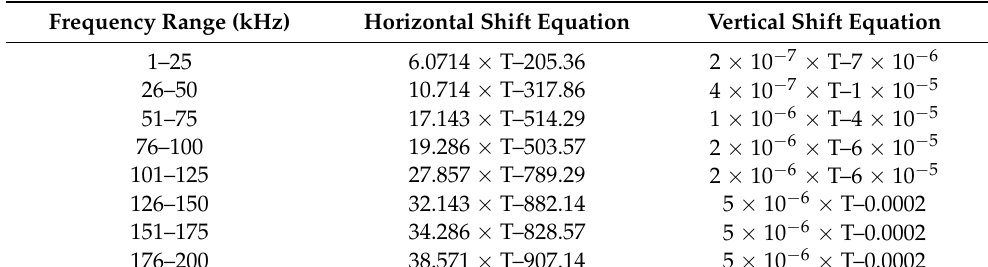
Table 1. Compensation shift equation for the admittance signatures.